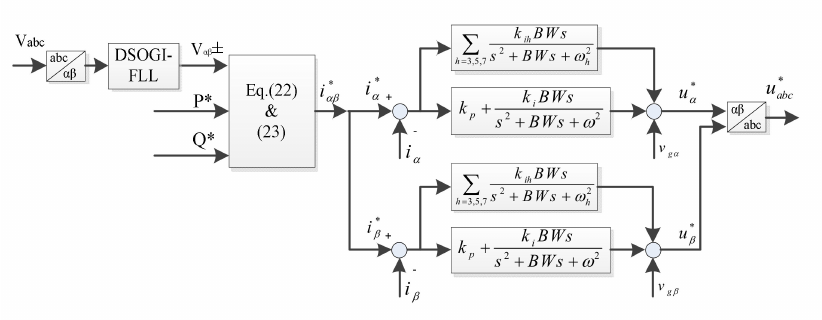
Figure 11. The inverter current control loop by implementing the instantaneous active–reactive control (IARC) method.